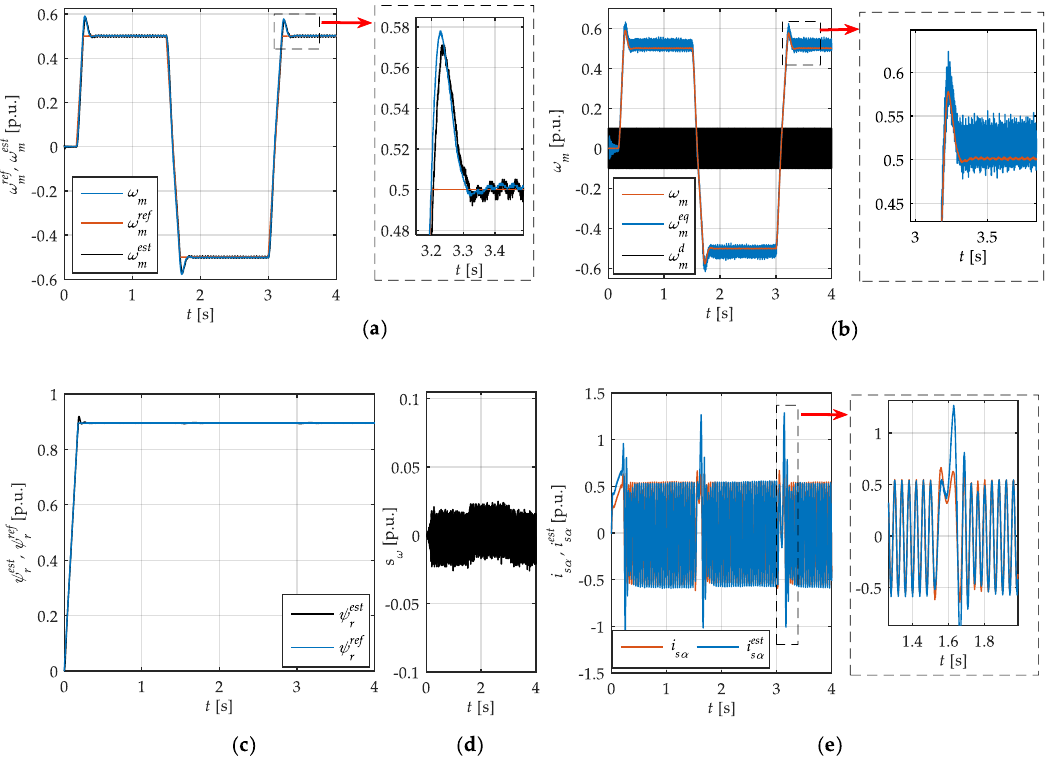
Figure 7. Performance of the speed estimation in the case of non-faulty operation of the IM: ( a ) Reference and estimated (9) speeds; ( b ) real speed, continuous (10a), and discontinuous (10b) parts of the estimated speed; ( c ) reference and estimated amplitude of rotor flux (7); ( d ) speed switching function